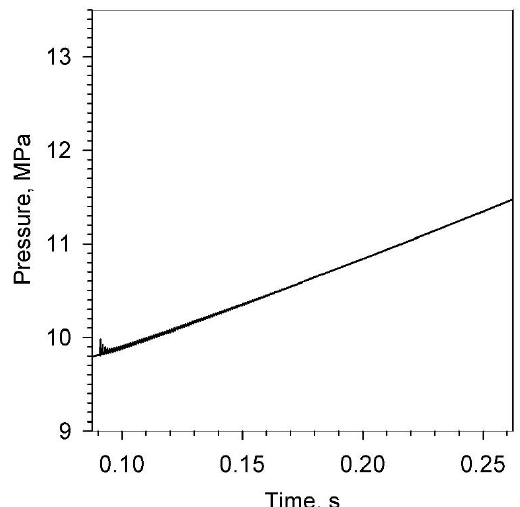
Figure 7. Predicted head-end pressure-time profile, reference motor ( K Δ H = 150,000 J/kg, α s